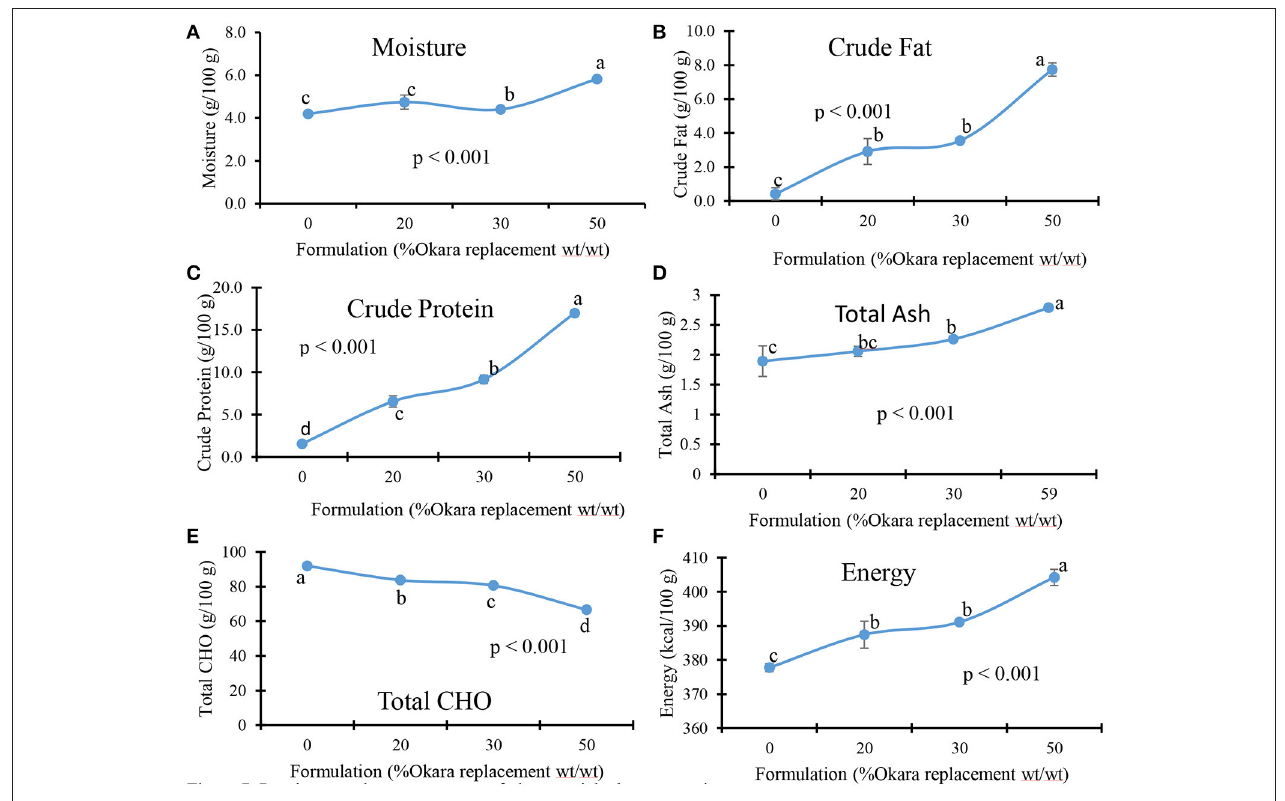
FIGURE 7 | Proximate and energy content of okara-enriched cassava grits. Except for moisture, all determinations are on dry matter basis. Values are means ± SD; n = 3. Data points with the same letters are not significantly different after ANOVA and means compared using LSD test ( p > 0.05). Proximate [Moisture (A) , Crude fat (B) , Crude Protein (C) , Total Ash (D) , Total CHO (E) ] and energy (F) content of okara-enriched cassava